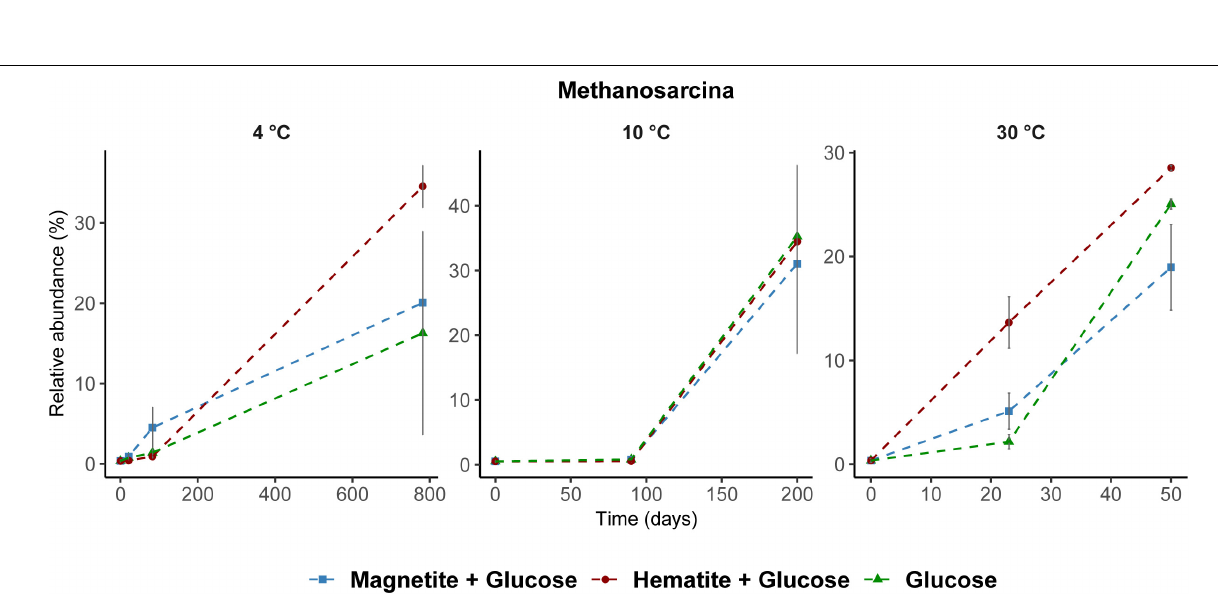
Frontiers in Microbiology |